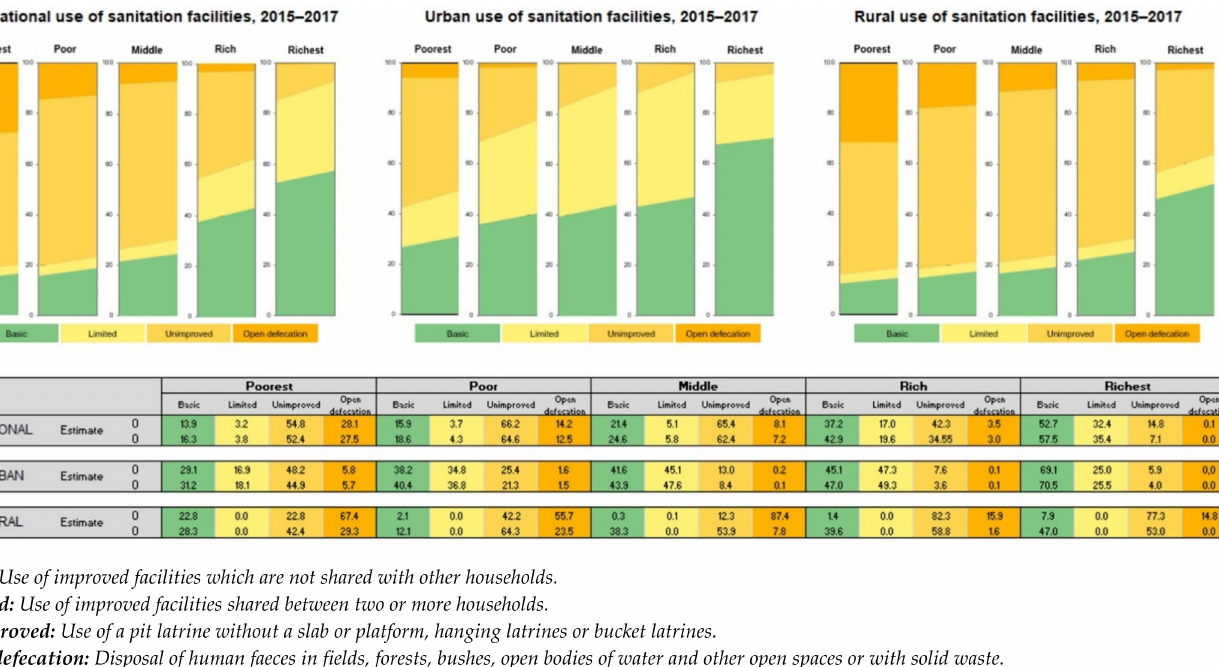
Figure 1. Summary of the trends in the use of sanitation facilities by wealth quintiles (%), United Republic of Tanzania, 2015–2017. JMP metrics